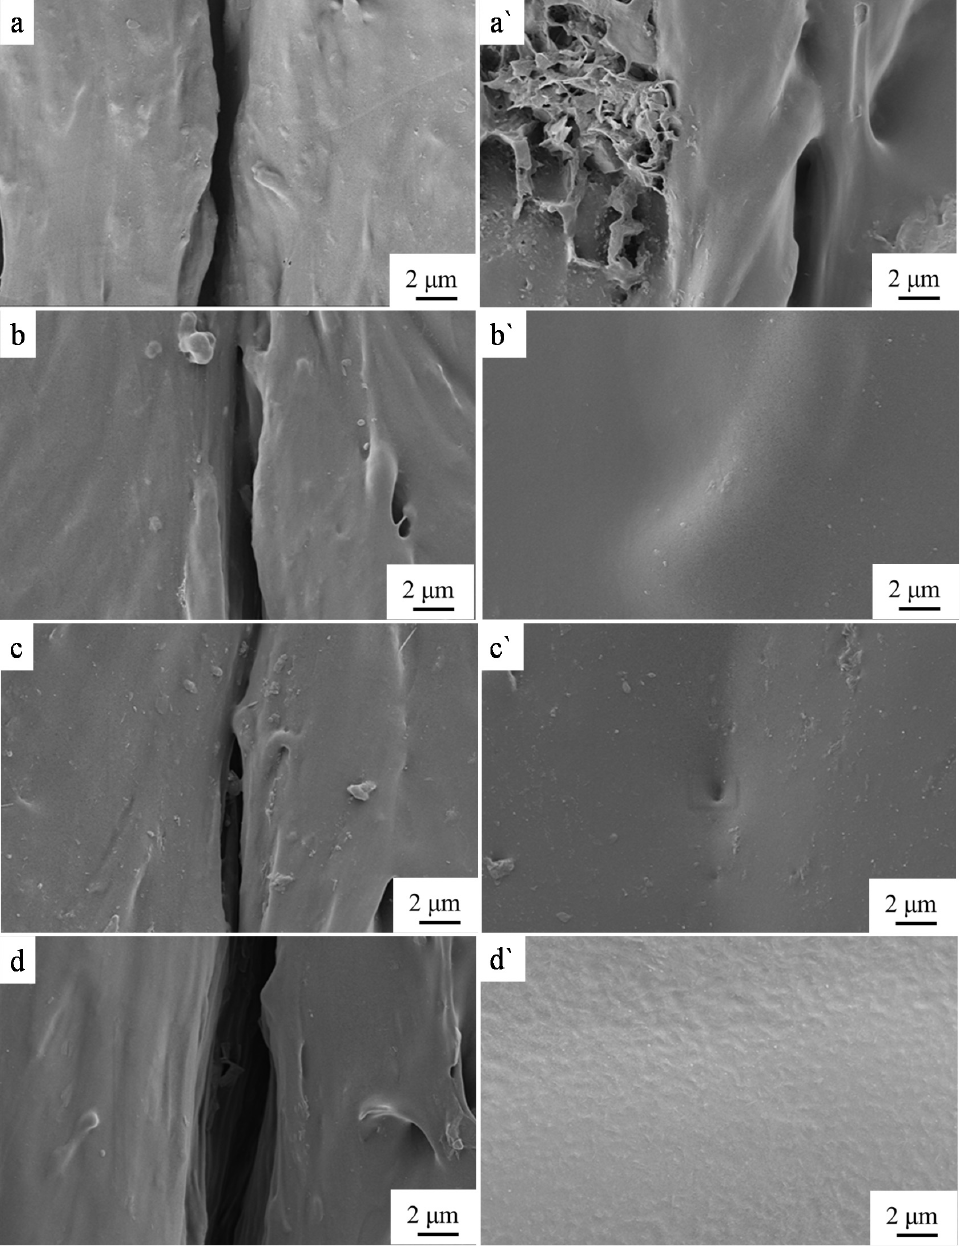
Figure 13. SEM images of the pure TPU ( a , a` ) and the GO-TPU films with the loading of the GO of 1 wt % ( b , b` ), 3 wt % ( c , c` ), and 5 wt % ( d , d` ) under the irradiation of an infrared lamp with an infrared light intensity of 3450 lux for 10 min. In order to study the effect of the initial concentration of TPU on the self-healing per- films with 2 wt % and the initial concentration of TPU of 10 wt %, 20 wt %, and 30 wt %, respectively, by using optical image. It can be seen from Figure 14 that three samples with different initial TPU concentrations are basically completely repaired after irradiation un- der the infrared lamp for 10 min. However, when the initial concentration of TPU is 10 wt %, there is obvious dents around the scratch. When the initial concentration of TPU is 30 wt %, the sample surface becomes uneven. Only when the TPU concentration is 20 wt %, the whole sample is still smooth and flat. This may be that the TPU around the scratch undergo thermal movement at the low initial concentration of the TPU (10 wt %), and the scratch is filled under the action of gravity, resulting in a decrease in the surrounding